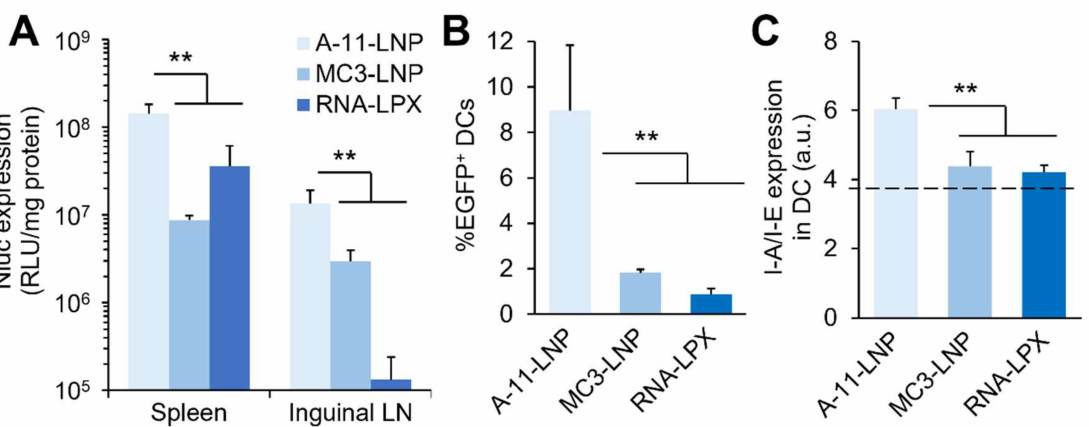
Figure 4. Comparison of the A-11-LNPs with clinically relevant formulations. ( A ) Nluc expression in spleen and inguinal LN 24 h after intravenous administration of Nluc-mRNA-loaded formulations at a dose of 0.5 mg mRNA/kg. ( B ) Percentage of EGFP + splenic DCs 24 h after the intravenous administration of EGFP-mRNA-loaded formulations at a dose of 0.5 mg mRNA/kg. ( C ) I-A/I-E expression in splenic DCs 24 h after intravenous administration of EGFP-mRNA-loaded formulations at a dose of 0.5 mg mRNA/kg. n = 3. ** p <